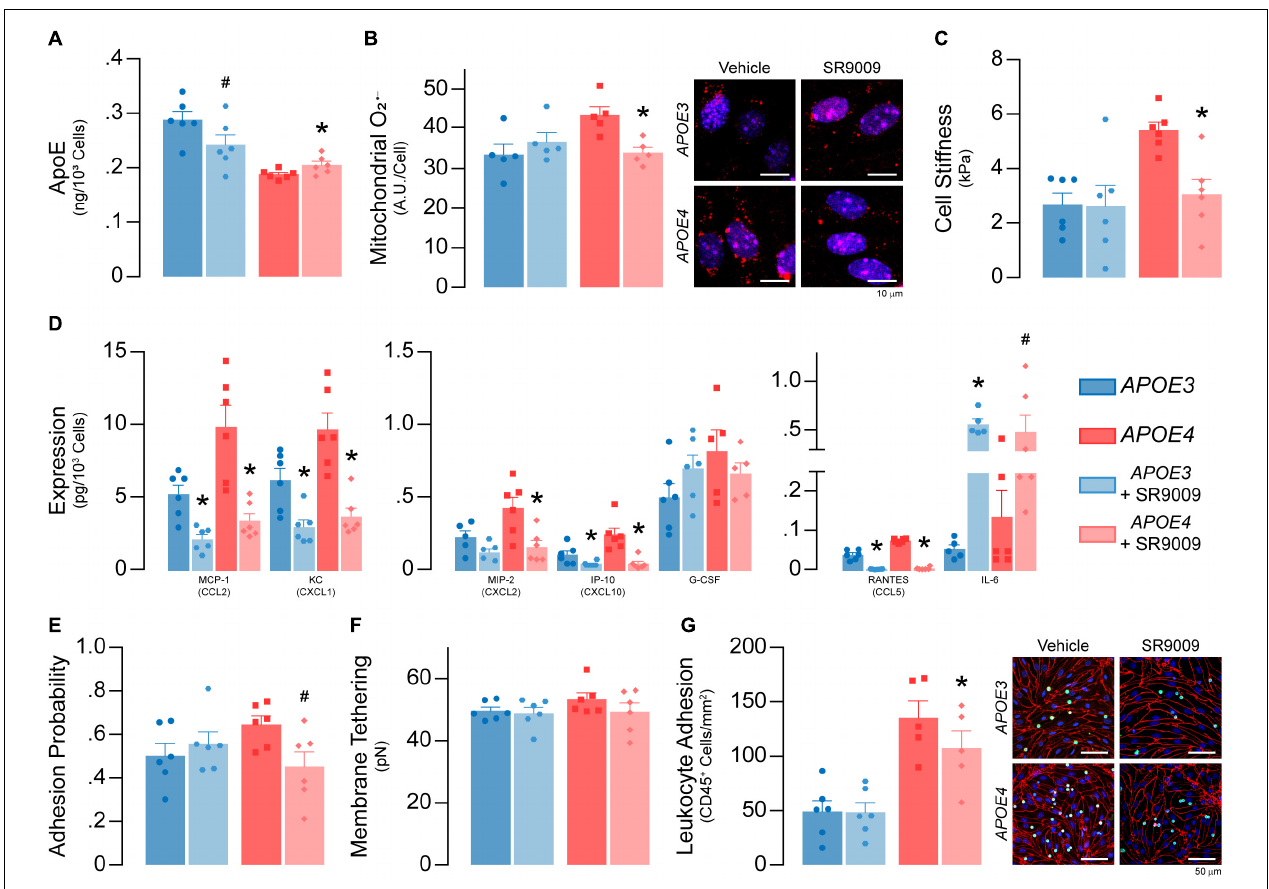
FIGURE 10 | SR9009 treatment impacts metabolism and inflammation in APOE4 brain endothelial cells. At confluence, brain endothelial cells were treated with 5 µ M SR9009 for the 48 h leading up to each assay. (A) SR9009 treatment results in lower apoE levels ( ∼ 16%) with APOE3 and higher levels ( ∼ 9%) with APOE4 when assessed by ELISA. (B) SR9009-treated APOE4 , but not APOE3 , brain endothelial cells have lower mitochondrial superoxide levels compared to the vehicle ( n = 5). (C) Cell stiffness is lower in SR9009-treated APOE4 , but not in APOE3 , brain endothelial cells (analyzed by paired t -test). (D) MCP-1/CCL2, KC/CXCL1, IP-10/CXCL10 and RANTES/CCL5 levels are lower with SR9009 in both APOE3 and APOE4 brain endothelial cells when assessed by multiplex ELISA. SR9009 lowers MIP-2 levels in APOE4 brain endothelial cells and increases IL-6 levels for both APOE3 and APOE4 endothelial cells. (E) The adhesion probability is lower in APOE4 brain endothelial cells with SR9009 treatment but (F) membrane tethering force is unaffected (analyzed by paired t -test). (G) Leukocyte adhesion is lower with APOE4 following treatment with SR9009 ( APOE3 n = 6, APOE4 n = 5). Data is expressed as mean ± S.E.M. * p < 0.05 by two-tailed Student’s t -test and # p < 0.05 by one-tailed Student’s t -test compared to vehicle control with n = 6 (unless otherwise specified